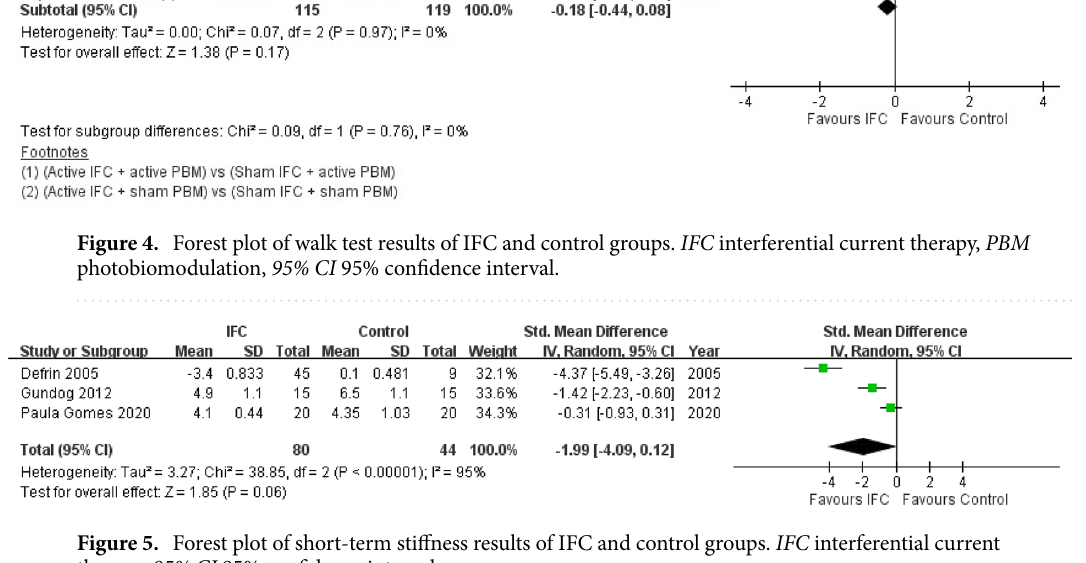
Figure 5. Forest plot of short-term stiffness results of IFC and control groups. IFC interferential current therapy, 95% CI 95% confidence